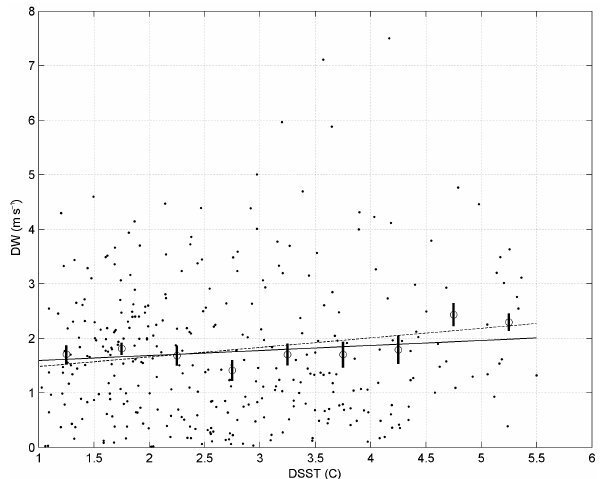
Figure 9. Scatter plot of SST perturbation (DSST) vs. wind speed increase (DW) in ms − 1 relative to wind conditions upstream of the eddy for the 340 cases when the wind increased above warm-core eddies and decreased downstream and for SST perturbation from the surrounding ocean >1 ◦ C. Solid line is a linear fit. The circle represent the means within each 1 ◦ C bin and the error bars repre- sent ± 1 standard deviation of the wind differences within each bin divided by the square root of the number of sample within each bin. The dashed line is a linear fit of the means within the